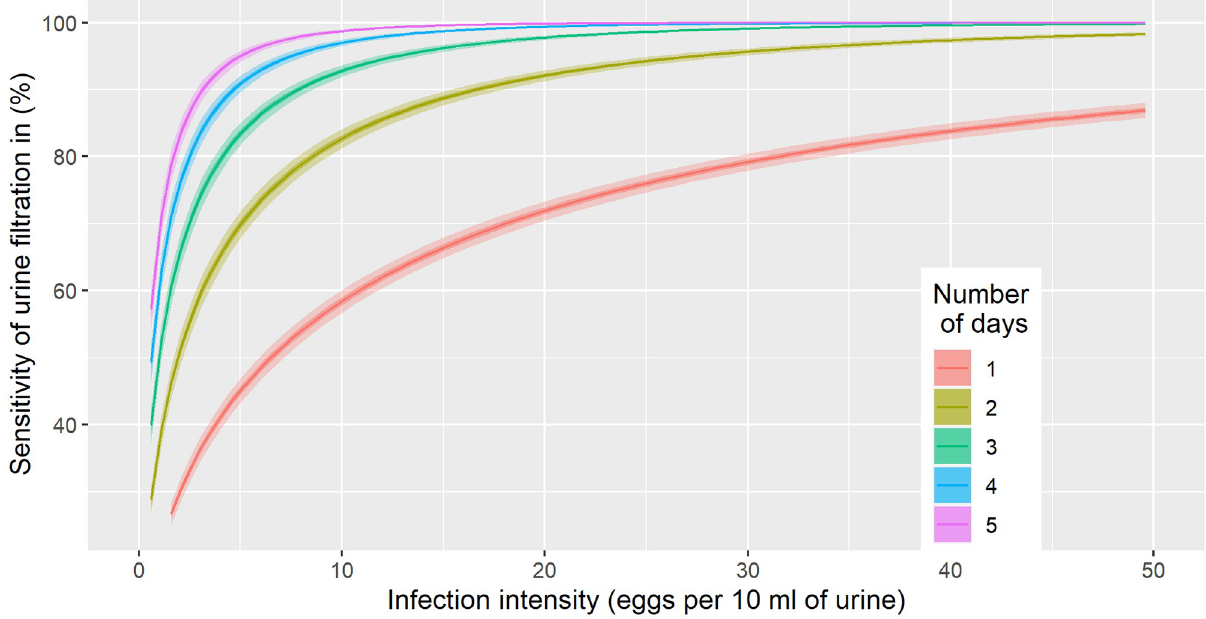
Fig 2. Sensitivity estimates of urine filtration (10 ml of urine) from a single to a total of five samples collected over consecutive days. Curves indicate posterior medians, while dark shaded areas provide a 50% and light shaded areas a 95% Bayesian credible interval.